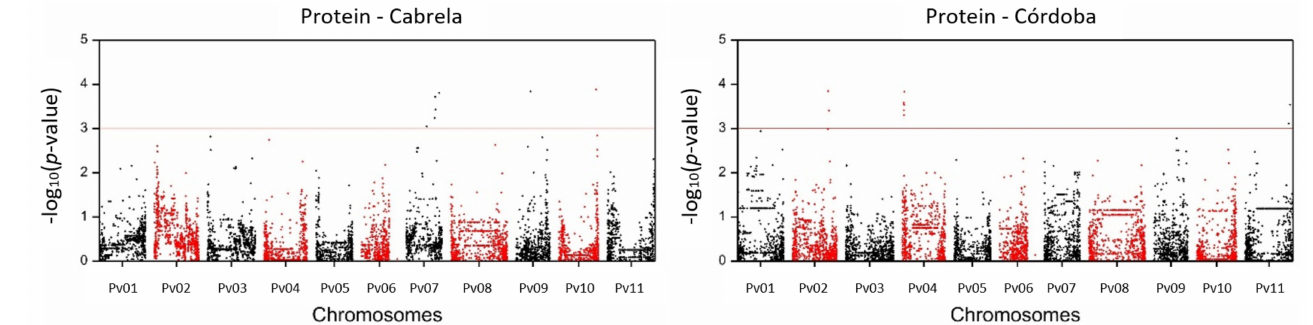
Figure 3. Manhattan plot depicting the genome-wide association results for protein content in com- mon bean using 78 Portuguese accessions grown in the Cabrela environment (left) and 94 Portuguese accessions grown in the C ó rdoba environment (right). The y-axis represents the − log 10 ( p -value) of 9601 SNPs and the x-axis shows their chromosomal positions across the common bean genome. The horizontal red line indicates the significance threshold ( p -value = 10 − 3